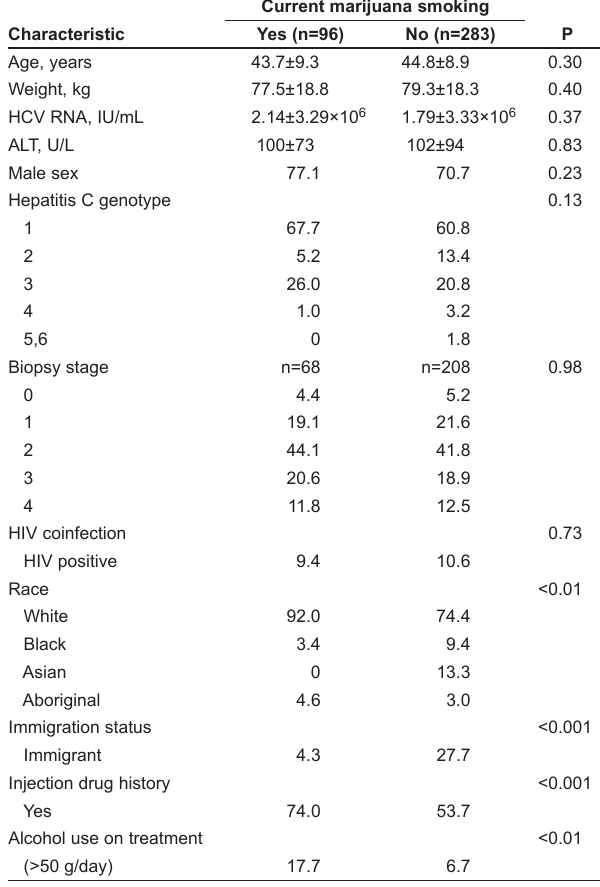
TAble 2 biopsy findings as a function of current marijuana smoking status